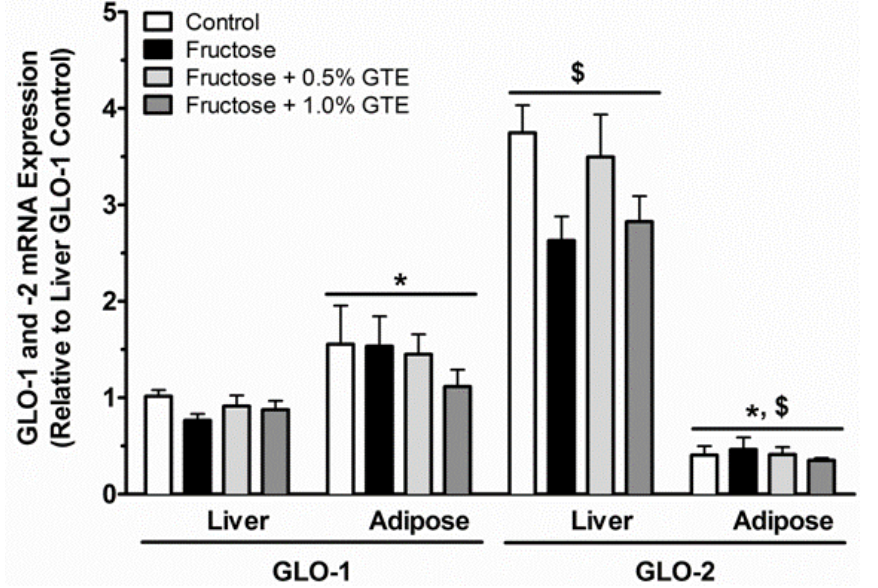
Figure 4. GLO-1 and GLO-2 mRNA expression in liver and adipose tissue. GLO-1 and GLO-2 mRNA expression are shown from rats fed a starch-based control diet containing 50% (w/w) starch and 10% (w/w) fructose (Control), a high-fructose diet containing 60% fructose (Fructose), the fructose diet containing 0.5% GTE (w/w) (Fructose + 0.5% GTE), or the fructose diet containing 1.0% GTE for nine weeks (Fructose + 1.0% GTE) (means ± SE; n = 8–9/group) . RNA was isolated using TRIzol and reverse transcribed by MMLV reverse transcriptase for RT-PCR analysis using the primers described in Methods and Materials. Data were normalized to GLO-1 mRNA in the control group and analyzed by 3-way ANOVA. Main effects of tissue and enzyme as well as tissue by enzyme interaction were all significant ( P < 0.01). There was no effect of diet ( P > 0.05) or interaction between diet and tissue ( P > 0.05) or group ( P > 0.05). A significant 3-way diet by tissue by enzyme interaction was observed ( P < 0.05), but no pairwise differences between diets were detected ( P > 0.05). *, significant difference between tissues for the same GLO enzyme ( P < 0.01). $, significant difference between GLO enzymes for within a tissue ( P <